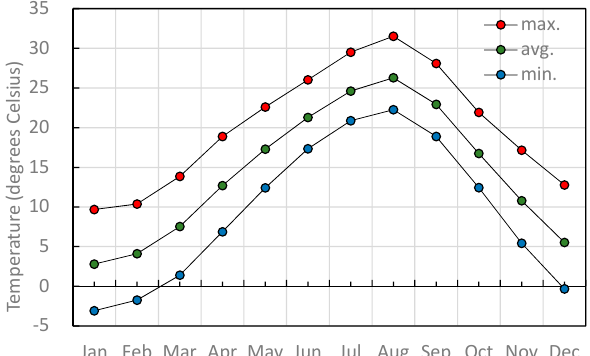
Figure 2. Maximum, average and minimum temperatures each month at Tsukuba exposure site.